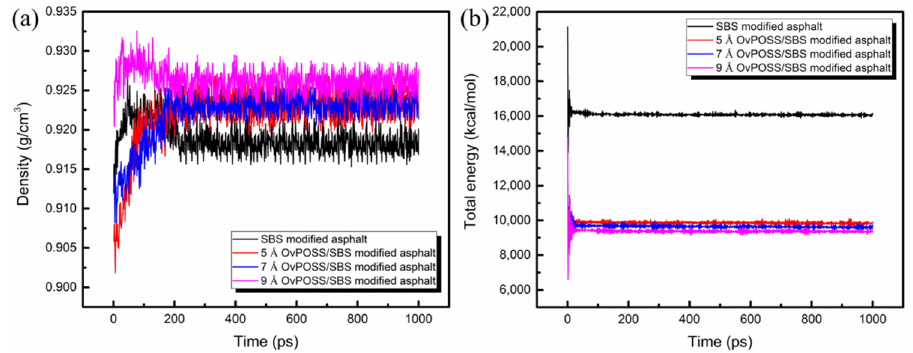
Figure 7. Model validation parameters: ( a ) density; ( b ) energy.